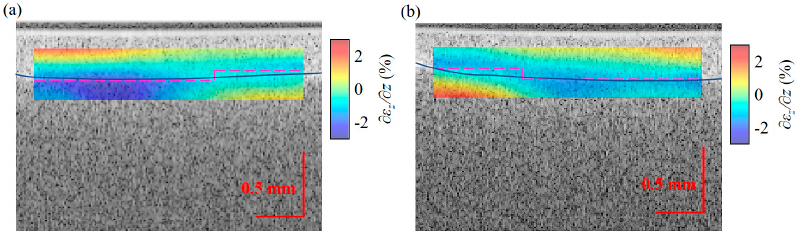
Figure 6. 3D strain fields of a double-layer phantom under compression. ( a – c ) Normal strains in the x , y and z directions respectively. The purple dashed lines in ( c-i ) and ( c-ii ) indicate the interface of the two layers. ( d – f ) Shear strains. Two strain maps shown underneath each of the 3D displays are the images of the cross-sections along the dashed lines.